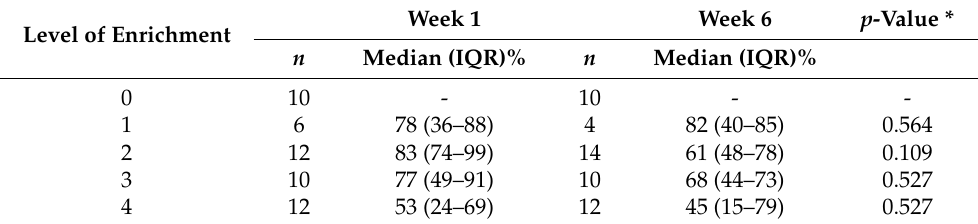
Table 4. Median intake (%) of the offered enrichment levels in week 1 and 6 of the intervention ( n = 50). Level of